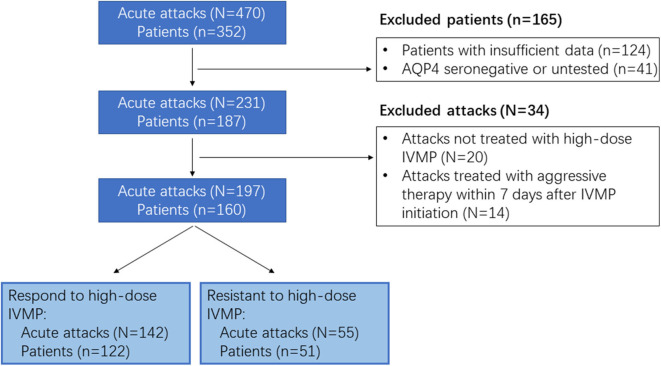
Flowchart of the present study. IVMP, intravenous methylprednisolone.